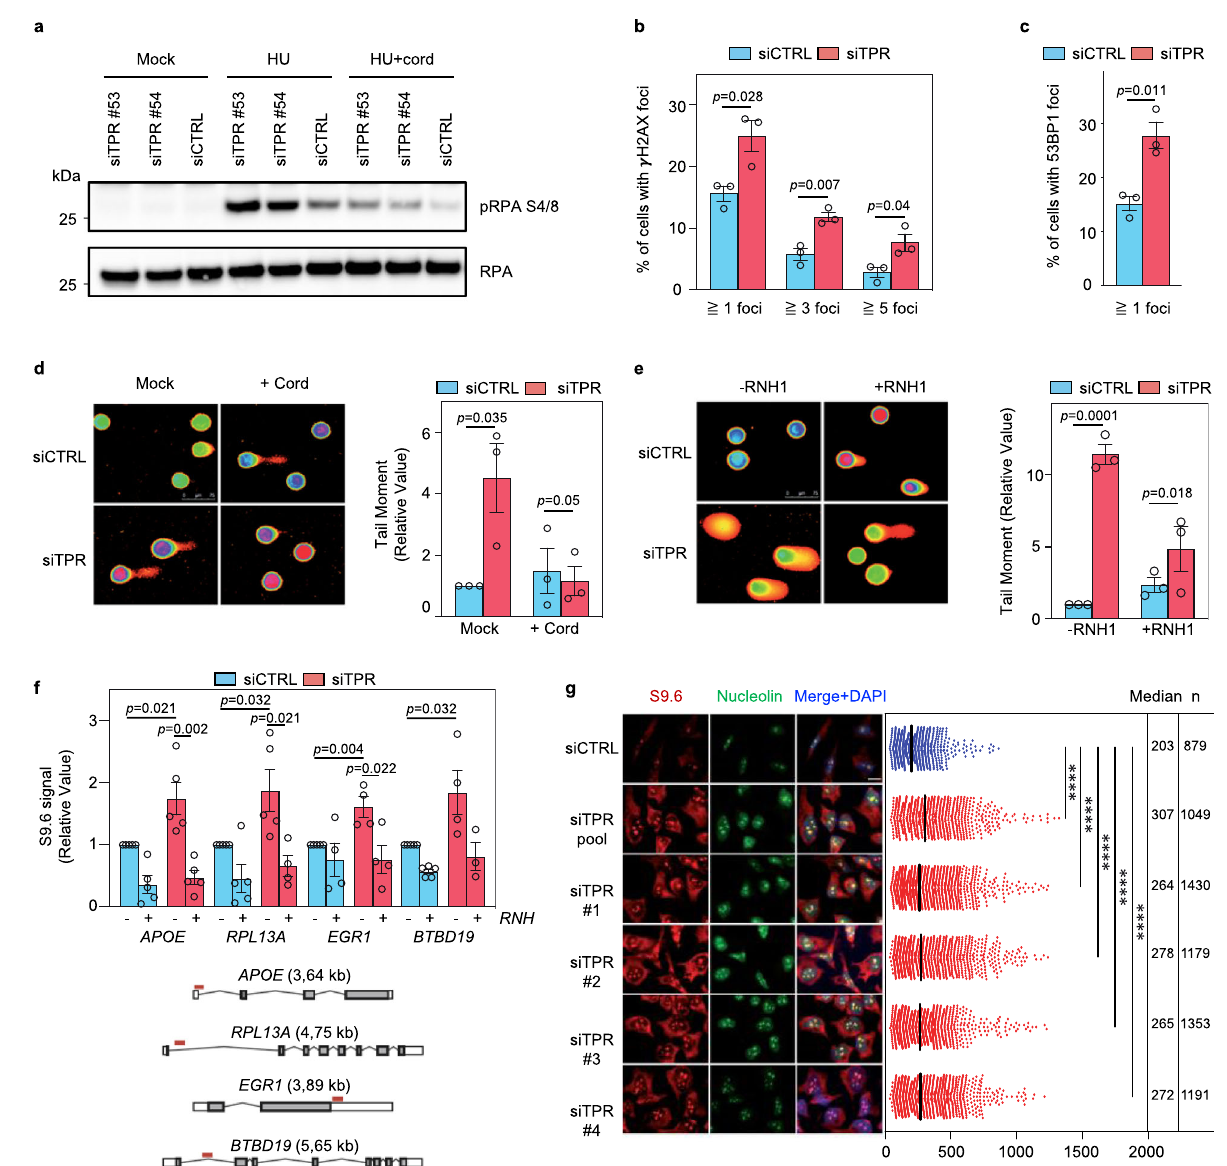
Fig. 3 Tpr depletion leads to DNA – RNA hybrid accumulation. a Tpr-depleted (siTPR) and control (siCTRL) cells. Treatments: nontreated (Mock); 2 mM hydroxyurea 4 h (HU); 50 μ M cordycepin 3 h followed by 2 mM HU 4 h (HU + cord). RPA total, loading control. Data are representative of three independent experiments. Source data are provided in the Source Data fi le. b Quanti fi cation of γ H2AX-foci in siTPR (red) and siCTRL (blue) HeLa cells. Data represent mean ± SEM from independent experiments ( n = 3). Statistical analysis: two-tailed unpaired Student ’ t test. c Quanti fi cation of 53BP1 foci in siTPR and siCTRL HeLa cells. Other details as in b . d DNA breaks in Tpr-depleted cells are transcription dependent. Alkaline comet assay in mock or cordycepin-treated ( + Cord) siTPR (red) or siCTRL (blue) HeLa cells. Representative images (left) and mean ± SEM of median comet tail moment (right) from independent experiments ( n = 3). Statistical analysis: two-tailed unpaired Student ’ t test. e RNaseH1 expression rescues DNA breaks in Tpr-depleted HeLa cells. Alkaline comet assay in siTPR (red) and siCTRL (blue) cells expressing RNaseH1 from plasmid pEGFP-M27-H1 ( + RNH1) or transfected with plasmid pEGFP-N2 ( − RNH1). Other details as in d . f DNA – RNA hybrid immunoprecipitation with the S9.6 antibody in siTPR (red) and siCTRL (blue) HeLa cells at the APOE , RPL13A , EGR1 , and BTBD19 genes. Where indicated samples were treated with RNase H (RNH) prior to immunoprecipitation. S9.6 signal values were normalized to the control cells value of each locus in each experiment. Location of the amplicon relative to each gene is indicated. Mean± SEM of signal values of R-loop detection obtained from independent experiments are shown ( n = 5, except for siTPR + RNH of RPL13A , siCTRL + RNH, and both siTPR of EGR1 , siTPR − RNH of BTBD19 for which n = 4, and siTPR + RNH of BTBD19 for which n = 3). Statistical analyses with a two-tailed unpaired Student ’ t test. g siTPR pool deconvolution analysis by S9.6 immuno fl uorescence in HeLa cells. Immuno fl uorescence with S9.6 and anti-nucleolin antibodies in siCTRL (blue), siTPR pool (siTPR pool; red), or each individual siRNAs of the siTPR pool (siTPR #1, siTPR #2, siTPR #3, siTPR #4; red) transfected cells. Representative images from three independent experiments (left) and quanti fi cation of S9.6 signal intensity per nucleus after the subtraction of the nucleolar signal (right). Scale bar, 7.5 µ m. Median value and number of cells ( n ) examined over three independent experiments are indicated. Statistical analysis: two-tailed unpaired Mann – Whitney U test; **** p < 0.0001.